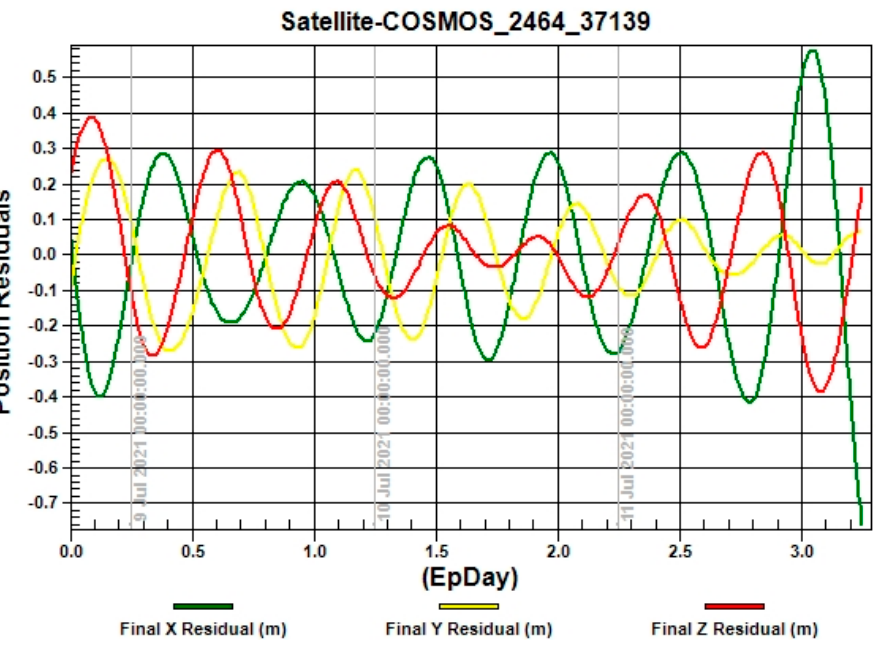
Figure 4. The relationship between the position residuals and the time for satellite“COSMOS-2464”.